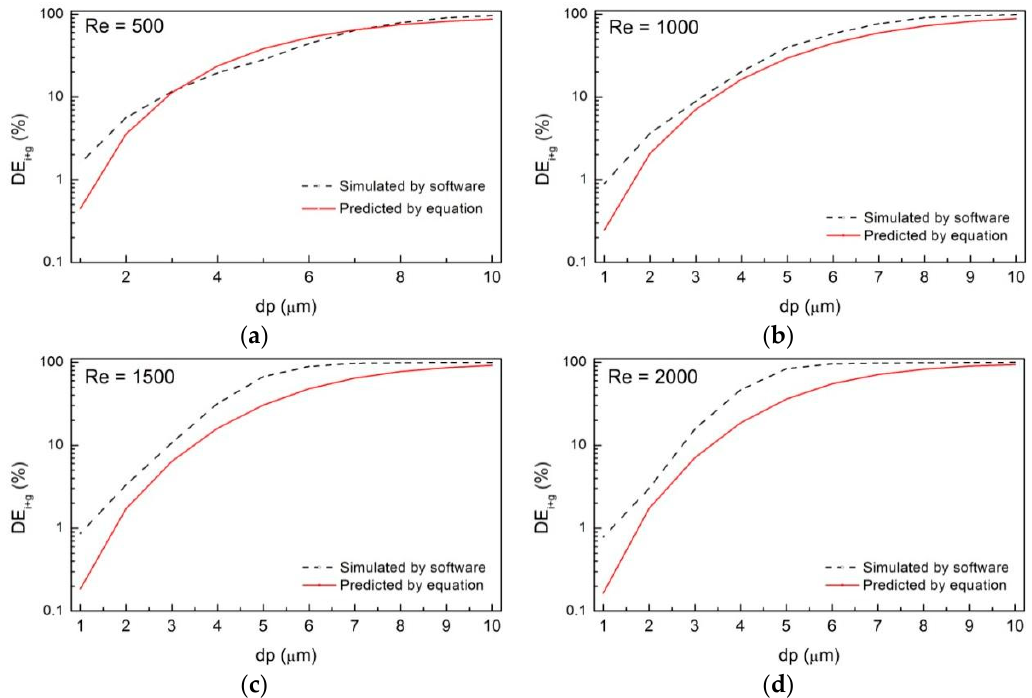
Figure 8. Comparisons of the values of DE i+g between the prediction and simulation, including ( a ) Re = 500; ( b ) Re = 1000; ( c ) Re = 1500; ( d ) Re = 2000. Table 1. The relative error between the prediction value and simulation value.